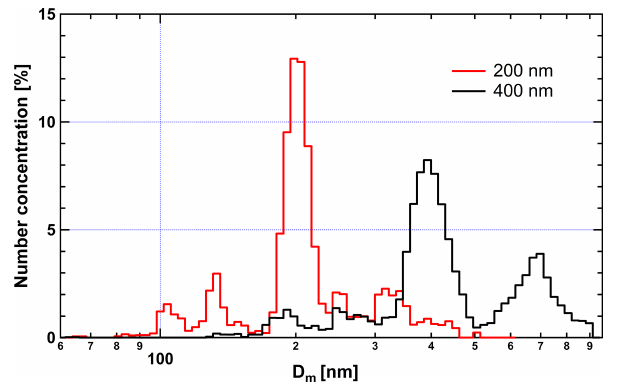
Figure A4. Number size distribution in terms of particle concen- tration percentage as a function of mobility diameter ( D m ) for 200 and 400nm size-selected FW200 bare soot